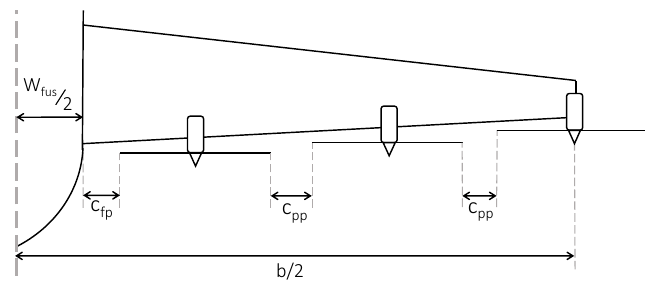
Figure 5. Definition of the fuselage–propeller and propeller–propeller clearances used in the lateral positioning of the